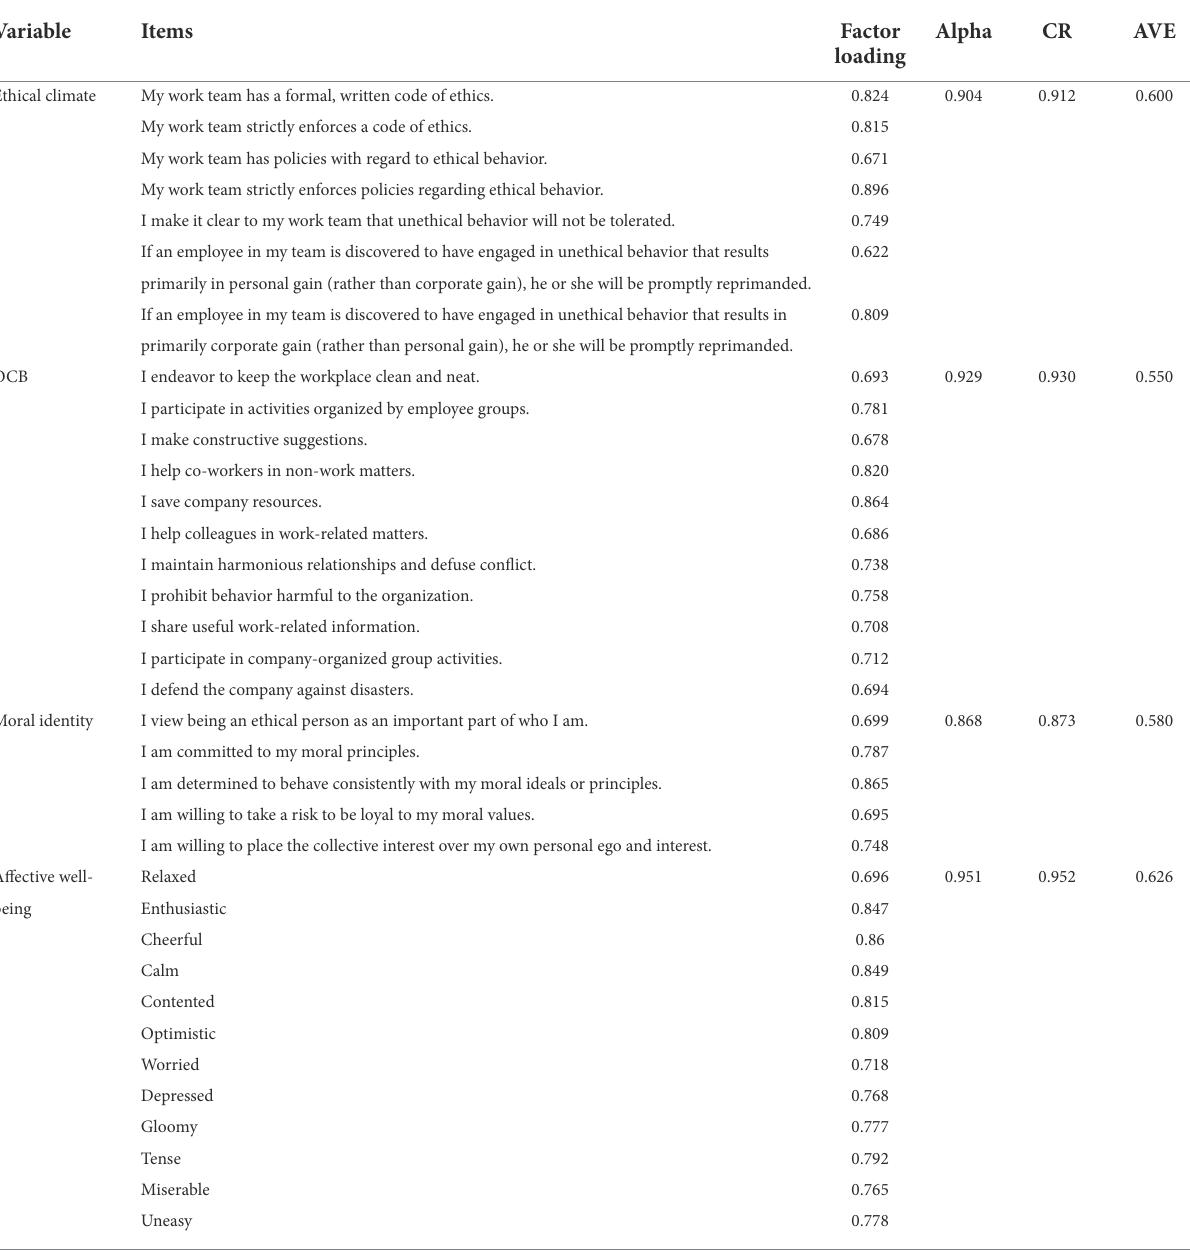
TABLE 1 Scale reliability and